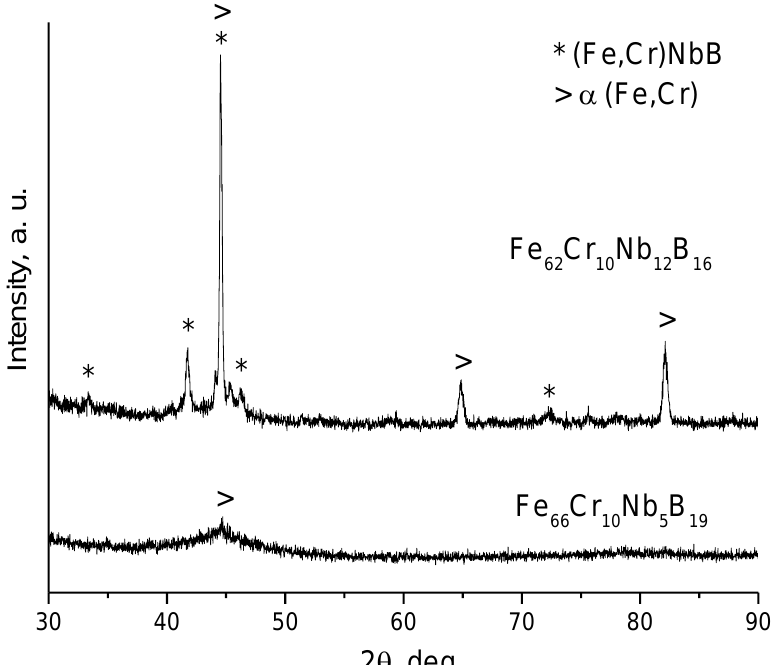
Figure 3. XRD patterns of the glassy Fe 66 Cr 10 Nb 5 B 19 alloy and crystalline Fe 62 Cr 10 Nb 12 B 16 alloy powders. (Fe,Cr)NbB has a hexagonal structure (space group P 6̅ 2m).